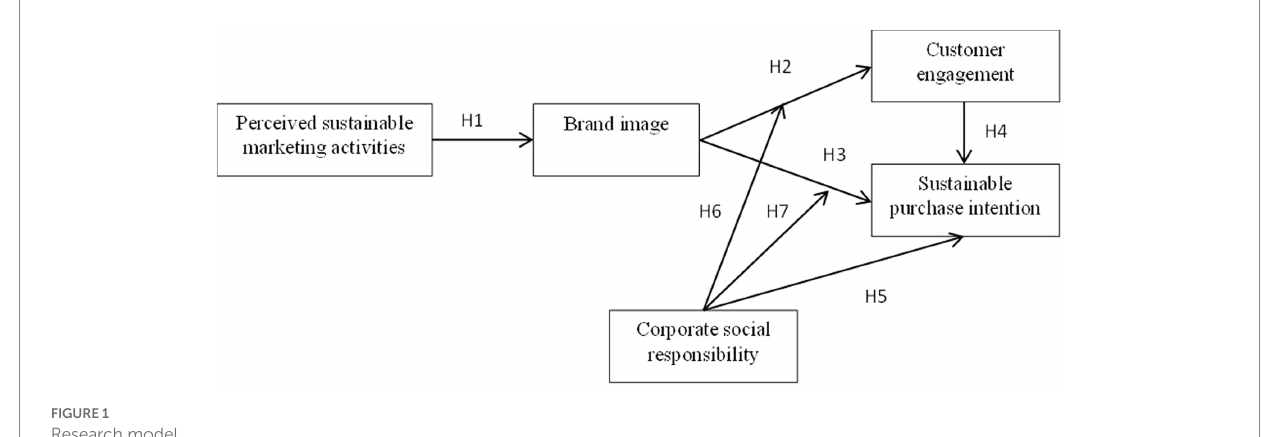
FIGURE 1 Research